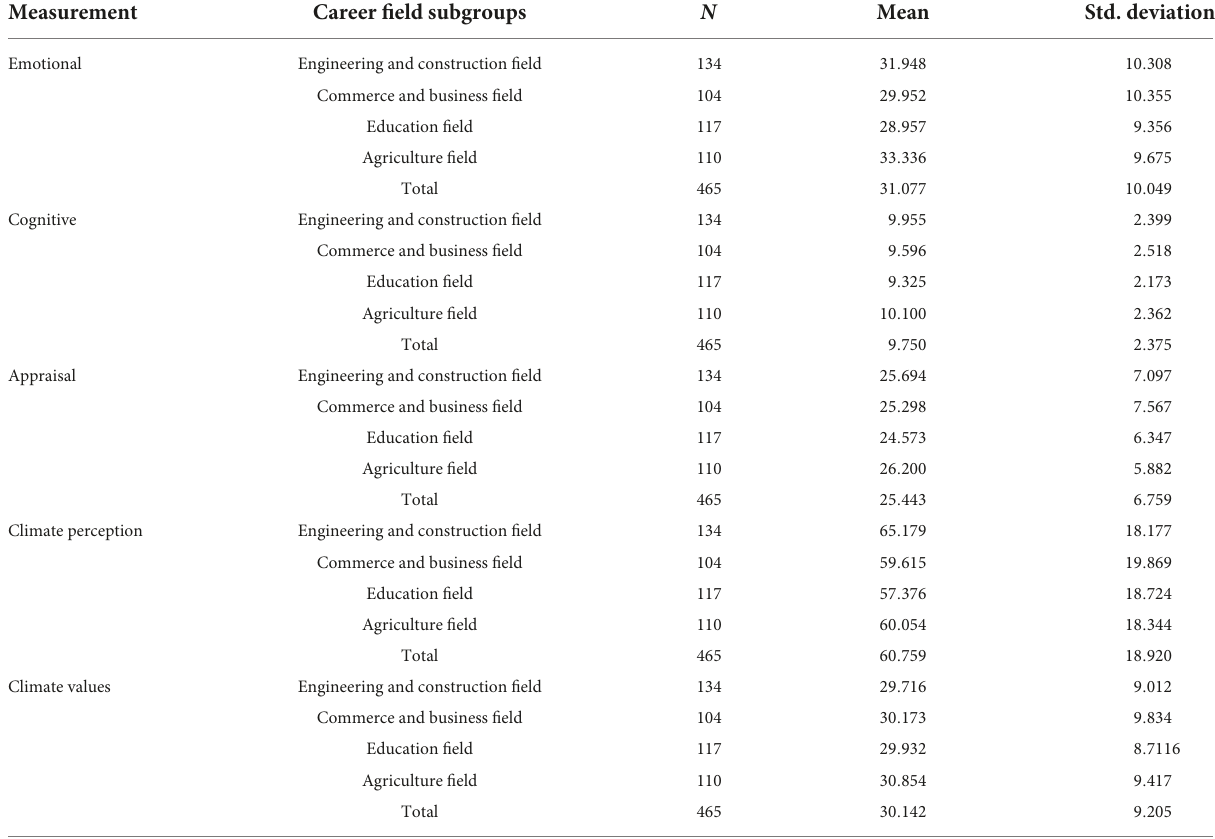
TABLE 5 Differences in climate change perception (CCP) and climate values (CV) due to career field variable. Measurement Career field subgroups N Mean Std. deviation Emotional